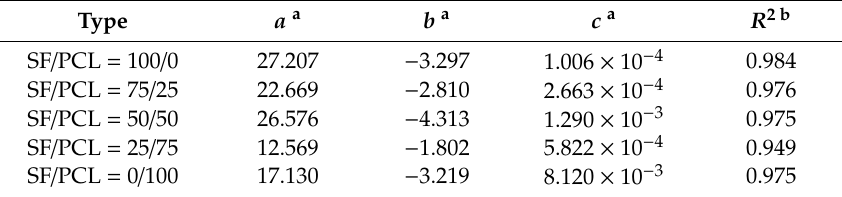
Figure 3. Typical stress–strain response of single nanofiber and its fitting equation. Table 1. Parameters obtained from the fitting of single nanofibers.